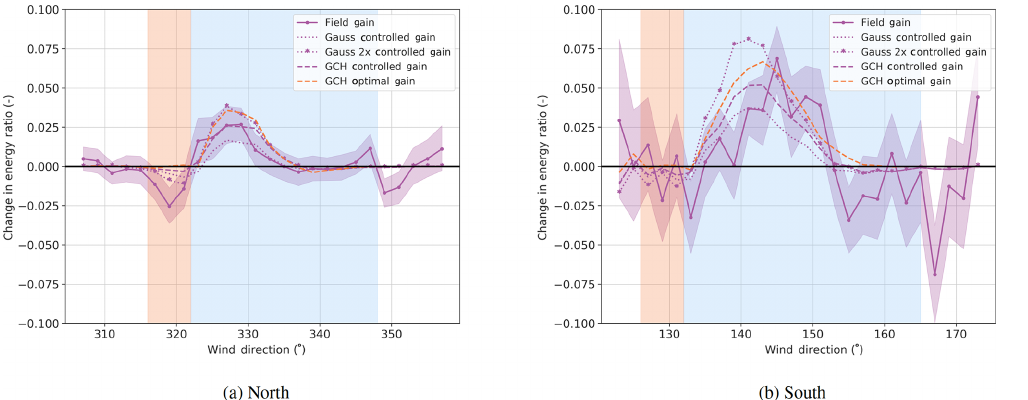
Figure 10. Combined change in energy ratio, which is the total energy production of T2 and T3 for the North Campaign and T4 and T3 for the South Campaign.